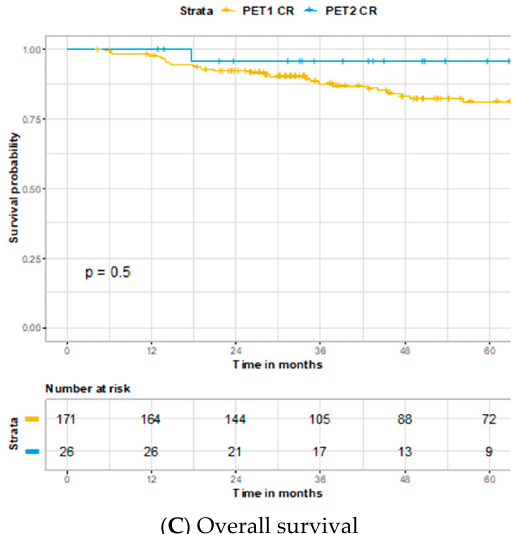
Figure 5. Kaplan–Meier curves comparing patients who achieved a complete response on initial PET/CT imaging versus those who achieved complete response on repeat PET/CT imaging: ( A ) Freedom from progression, ( B ) disease-specific survival, and ( C ) overall survival